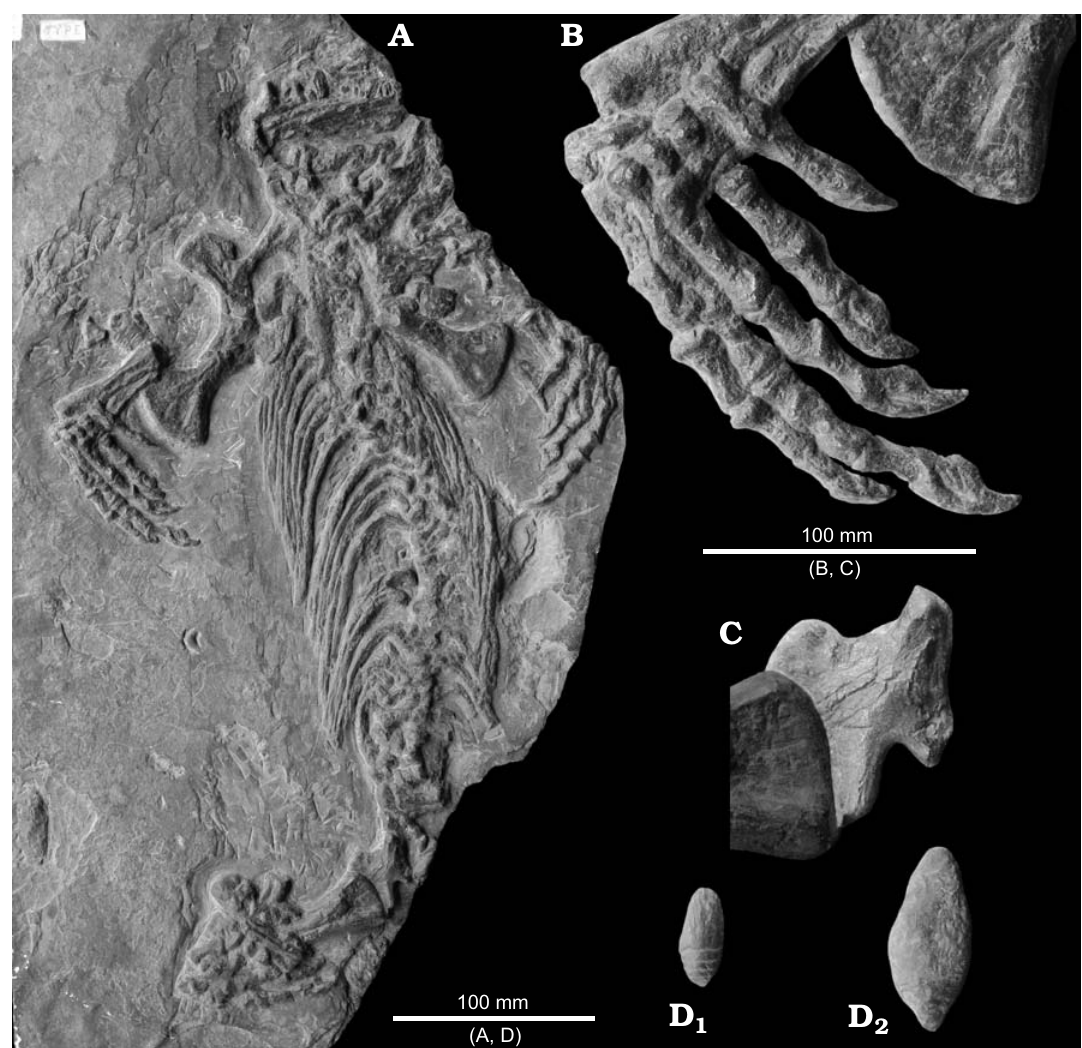
Fig. 1. Holotype of caseasaurian synapsid Callibrachion gaudryi Boule and Glangeaud, 1893 from Cisuralian of Autun, France (MNHN.F.AUT490). A . General view. B . Close-up of right manus. C . Right ilium, dorsally covered by proximal femur. D . Isolated shark coprolithes from the holotypic slab (Jörg W. Schneider, personal communication